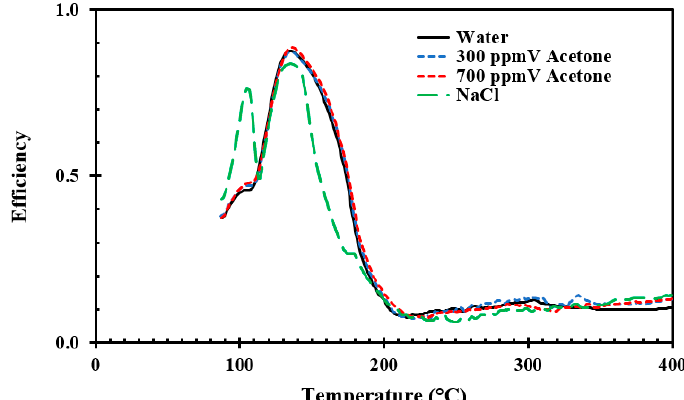
Figure 12. Cooling efficiency for pure water droplets with diameter 2.5 mm, various orientations at impingement height 25 cm and speed 2.2 m/s.